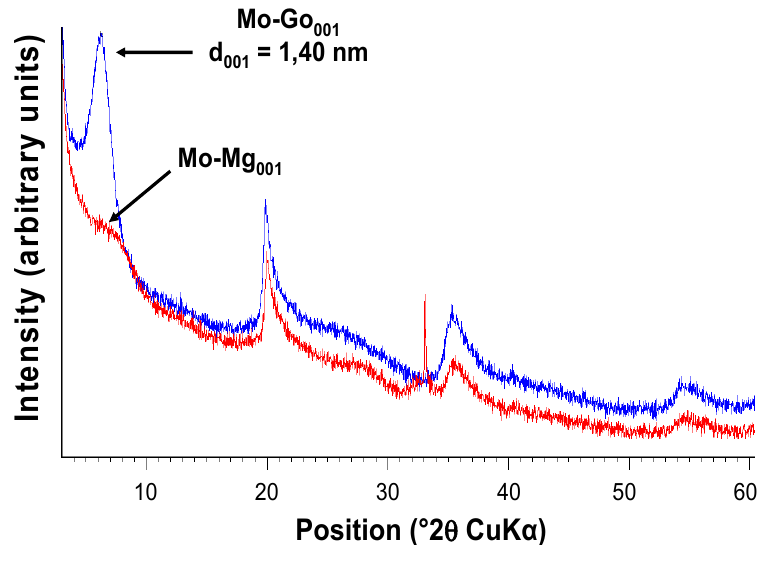
(blue) and Mo-Mag 001 001